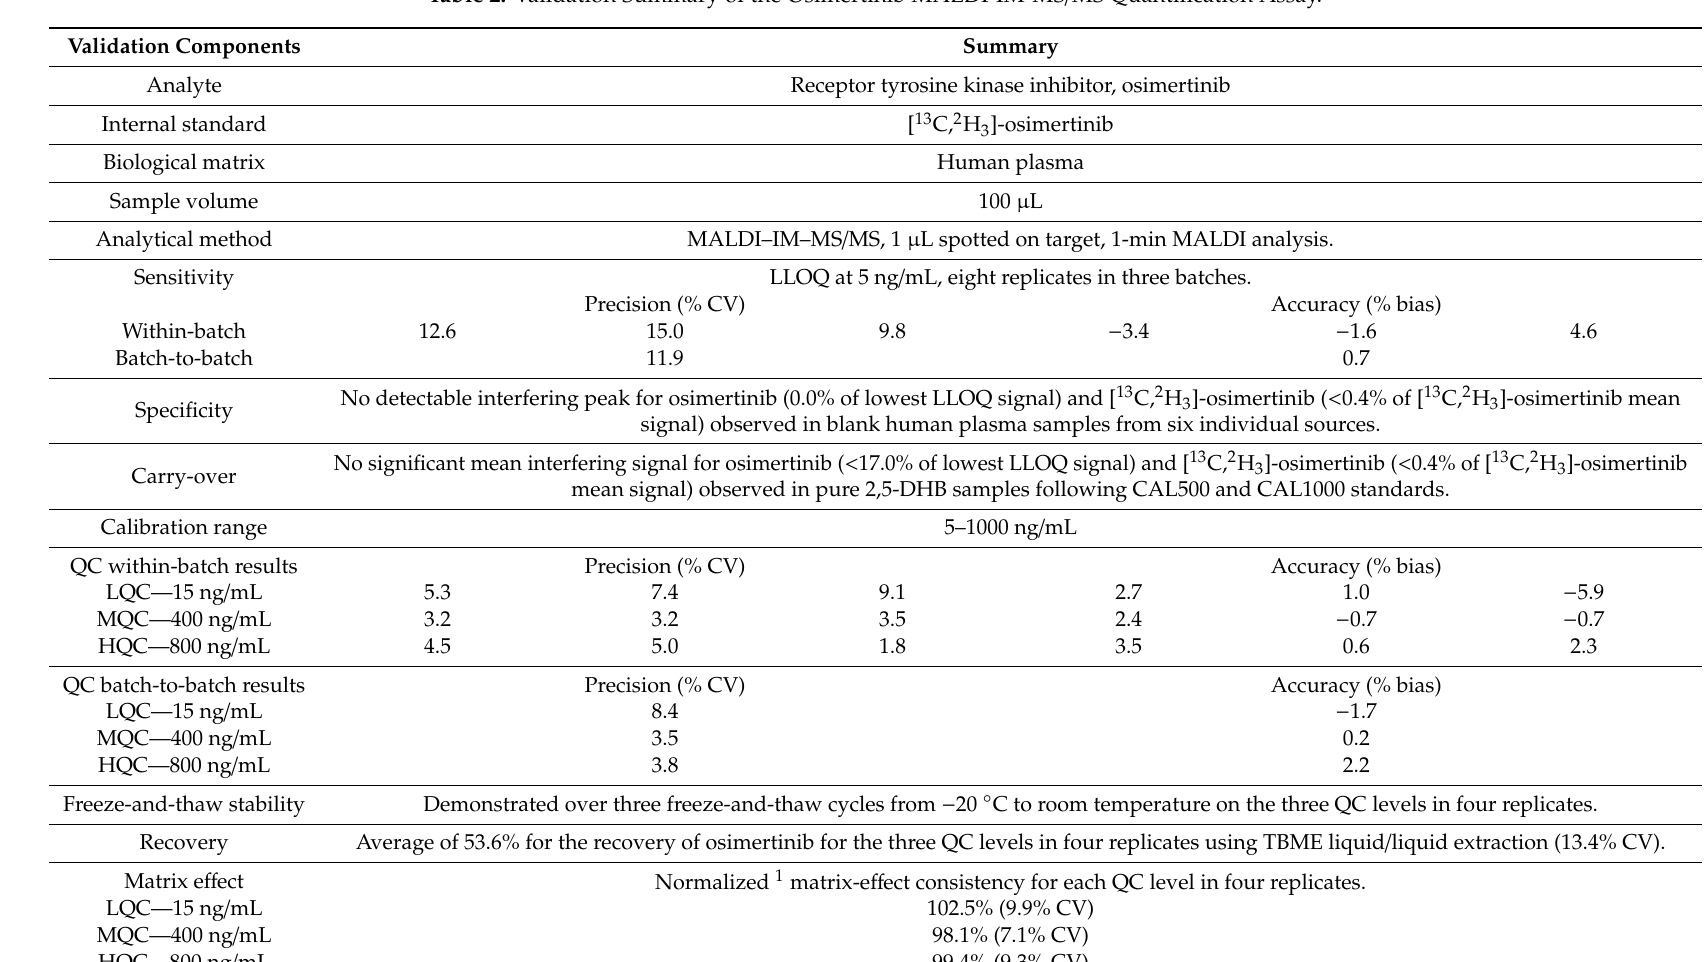
Table 2. Validation Summary of the Osimertinib MALDI-IM-MS / MS Quantification